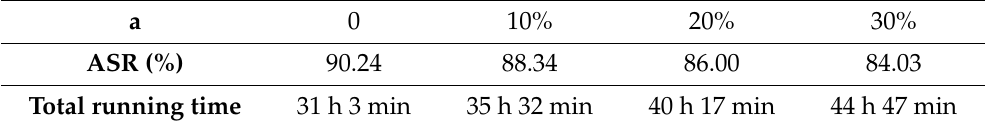
Table 5. Performance evaluation of adaptive FakeBob attacks with (cid:101) = 0.002 in generating adversarial audios in GMM SV systems without noise-adding.